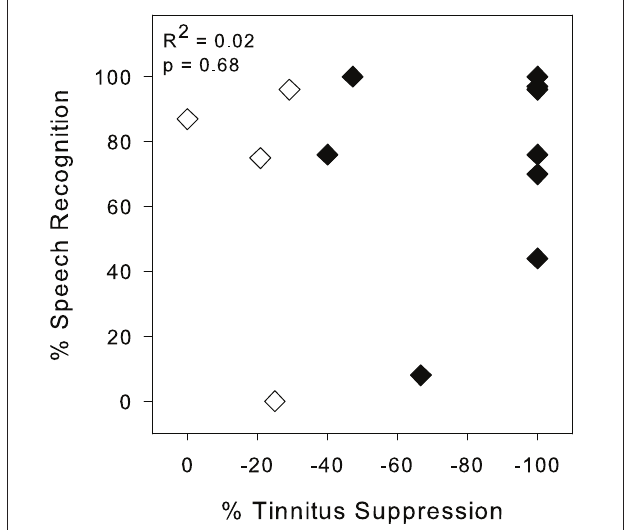
FIGURE 6 | Correlation of speech recognition with tinnitus suppression. The relationship between tinnitus suppression ( x -axis) and speech recognition scores ( y -axis) is shown for Responders (filled diamonds) and Non-Responders (open